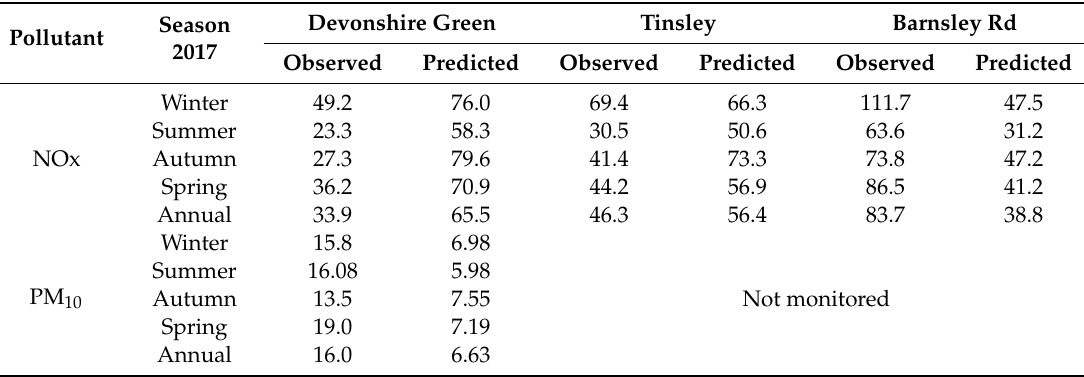
Table 3. Comparison of measured and predicted NOx and PM 10 concentrations ( µ g / m 3 ) at Devonshire Green, Tinsley and Barnsley Road AQMS in various seasons in the year